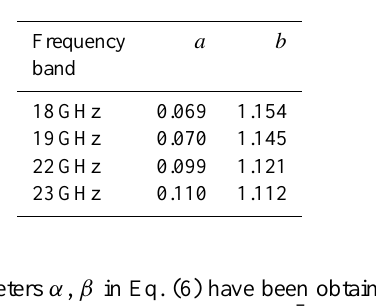
Table 2. Conventional power-law coefficients a , b for frequency bands in use, determined from α , β estimated using Eq. (26) for average link length of 3.43km.